Question: Express in one sentence what the figure is showing.
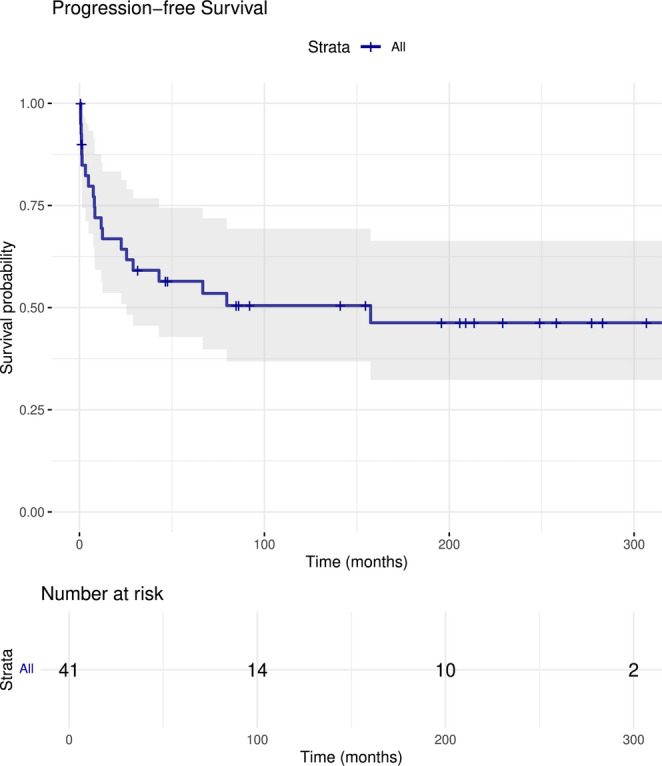
Answer: Kaplan–Meier overall study population (PFS)